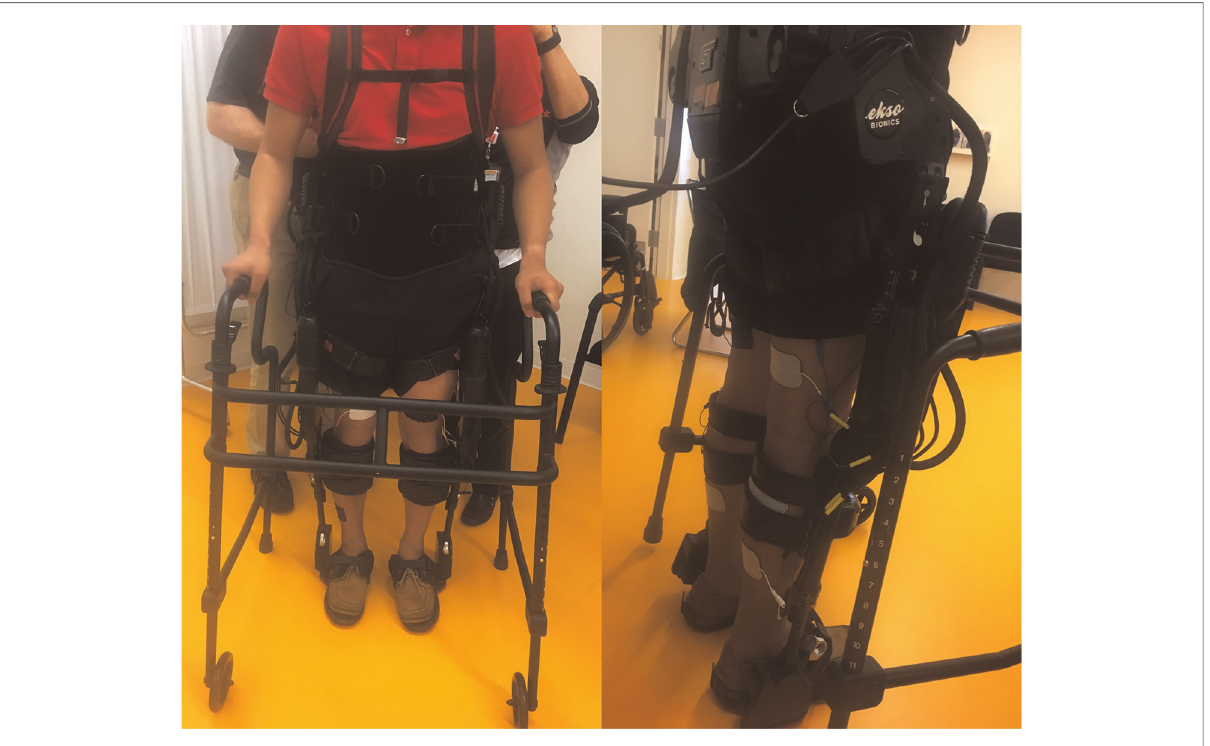
FIGURE 1 Left: intervention setup with both the exoskeleton and FES from the front. Right: intervention setup with both the exoskeleton and FES from the